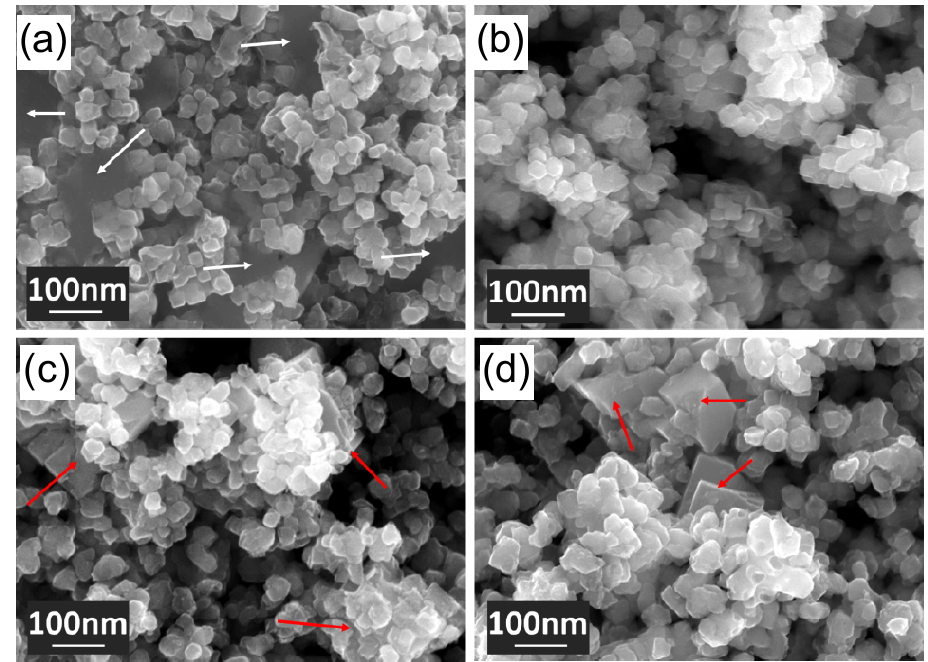
Fig. 2 FESEM images of the samples (a) STO-110, (b) STO-120, (c) STO-130, and (d)